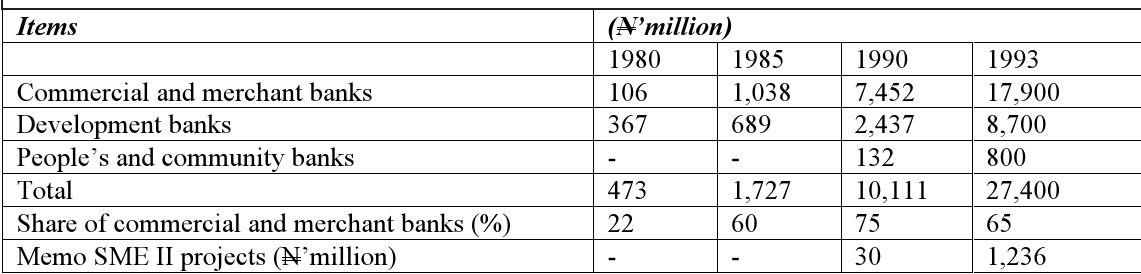
Table 9. Resource Flows to SMEs (1980–1993)